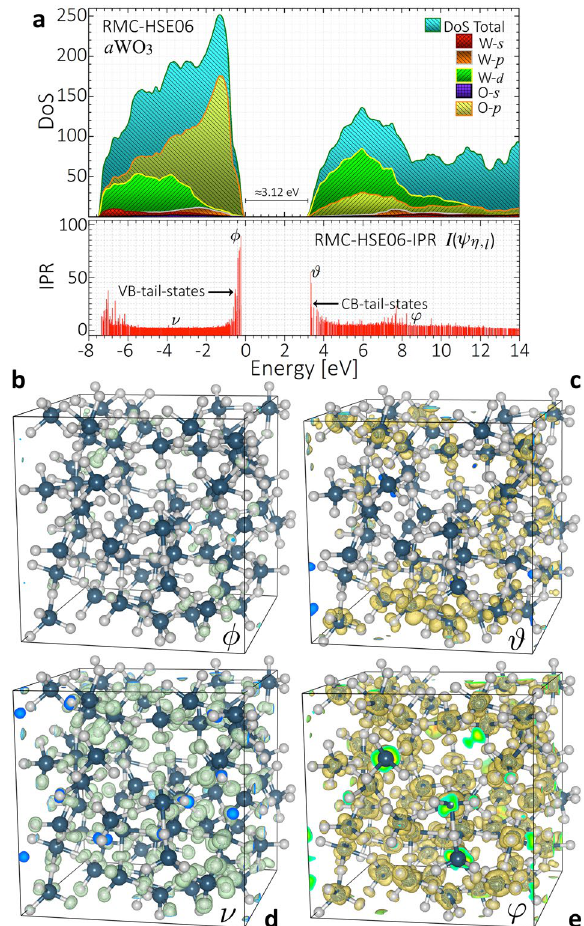
Figure 4. Electronic properties of a WO 3 . ( a ) Total and projected DoS for RMC-EXAFS optimized structures of a WO 3 and corresponding IPR, ψ η I ( ) function. ( b , c ) Electronic charge density contributions [Isosurfaces] to the l , localized VB and CB tail-states [ φ , ϑ ], and ( d , e ) delocalized Bloch-like VB and CB states [ ν , ϕ ], defined in Fig.